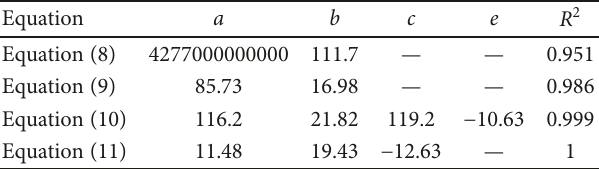
Figure 15: Relationship between porosity and tortuosity. Table 2: Fitting results for di ff erent equations.